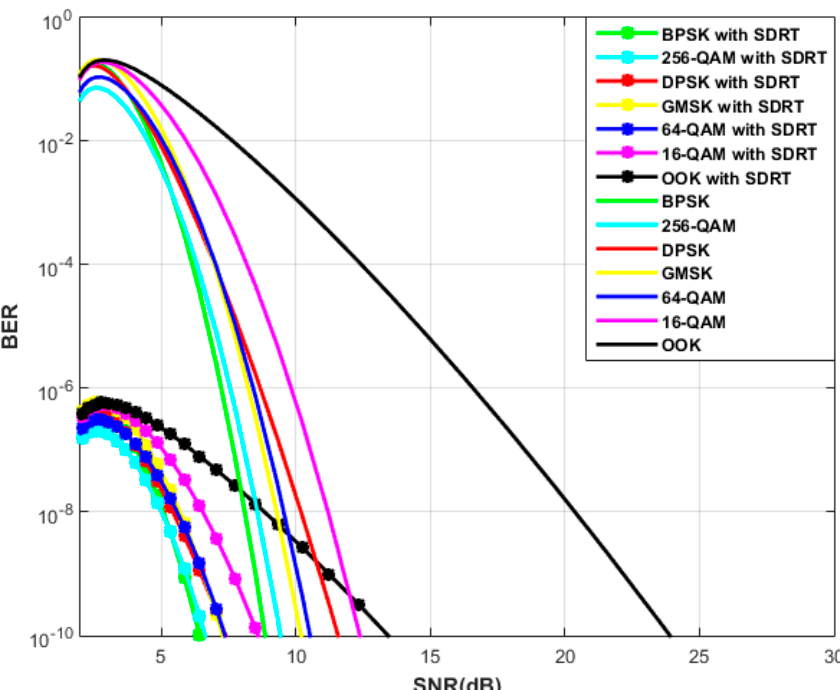
Figure 7. BER performance of different modulation formats with SDRT and without SDRT in a weak turbulence channel.